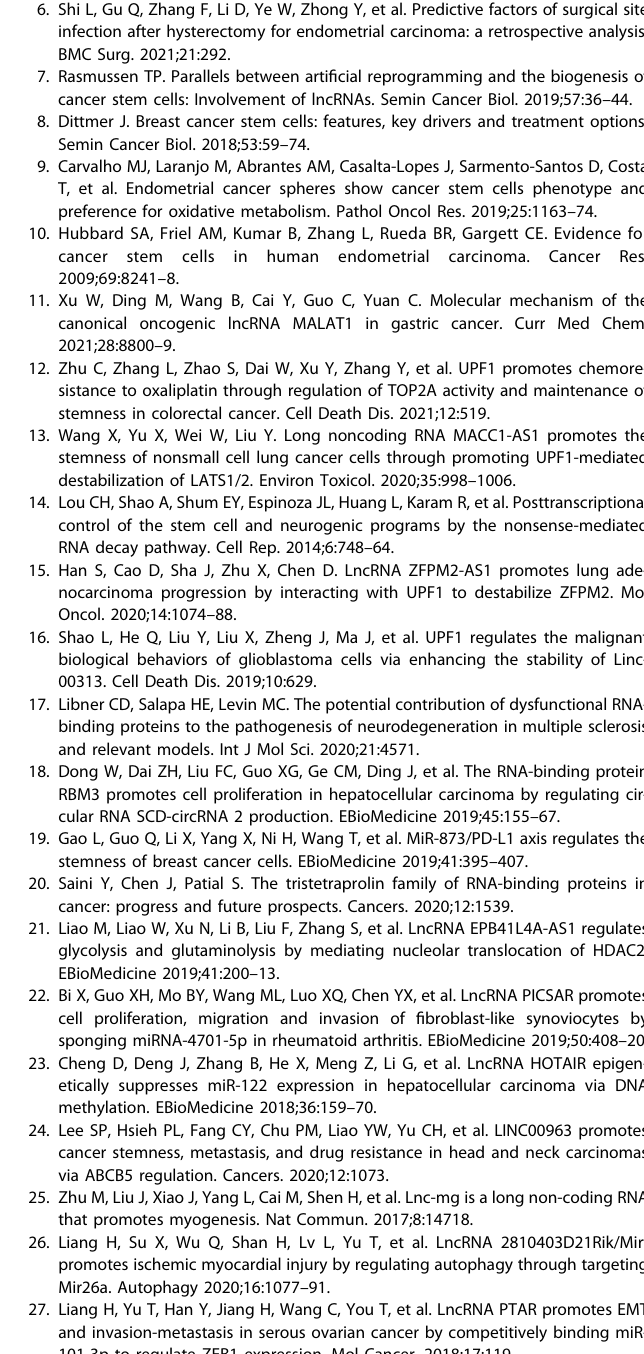
Fig. 8 UPF1 regulates ECSC initiation via the LINC00963/miR-508-5p axis in vivo. Tumorigenicity assessed by the A morphology, B volumes, and C weights of xenografts formed from ECSCs transfected with sh-NC and sh-UPF1 ( n = 3, each group). D Tumorigenicity initiating capacity of the minimum number of ECSCs transfected with sh-NC and sh-UPF1 ( n = 6, each group). E The nude mice carrying tumors from the respective groups are shown. The sample tumors from the respective groups are shown ( n = 3, each group). F Tumor growth curves are shown ( n = 3, each group). G Expression of SOX2, OCT4, and NANOG from the respective groups assessed using western blotting ( n = 3, each group). The results are presented as the ratio of the integrated density values of SOX2, OCT4, and NANOG versus Tubulin. The graphs represent the alteration in relation to the control group (protein of interest/Tubulin equal to 1). H Apoptosis of tumors from the respective groups detected using TUNEL assays ( n = 3, each group). I The primary and secondary spheres numbers of xenograft-derived cells detected by serial sphere formation assay ( n = 3, each group). J The proposed mechanism underlying the UPF1/LINC00963/miR-508-5p/SOX2 axis in ECSCs. Data are presented as the means ± SEM ( n = 3, each group), * P < 0.05, ** P < 0.01, *** P < 0.001 vs. Control group, # P < 0.05, ## P < 0.01 vs. sh-UPF1 group, △△ P < 0.01 vs. sh-LINC00963 group, ▲ P < 0.05, ▲▲ P < 0.01 vs. Agomir-508-5p group. Scale bars, 50 μ